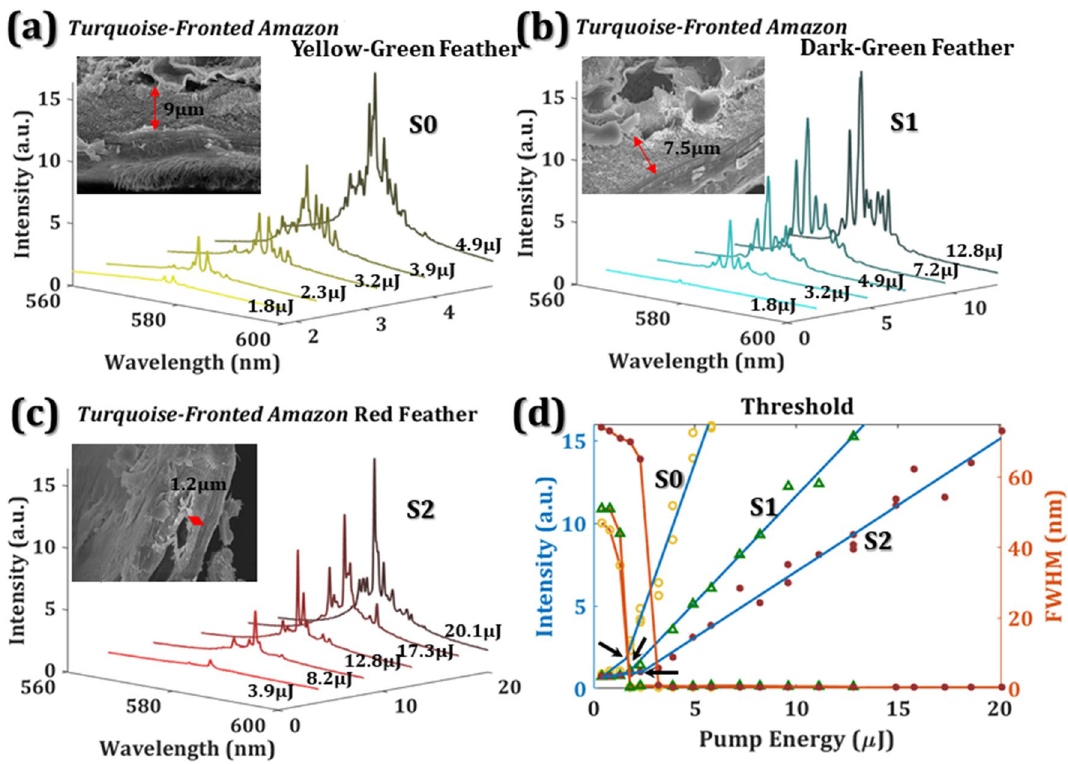
Figure 3. The emission spectra of Turquoise-Fronted Amazon ( a ) yellow-green feather S0, ( b ) dark-green feather S1, and ( c ) red feather S2. ( d ) The thresholds of the bird feather random lasers. Three black arrows indicate the threshold of 1.59 μJ, 1.7 μJ, and 2.4 μJ, respectively. The hollow circle, triangle, and solid circle represent the S0, S1, and S2,